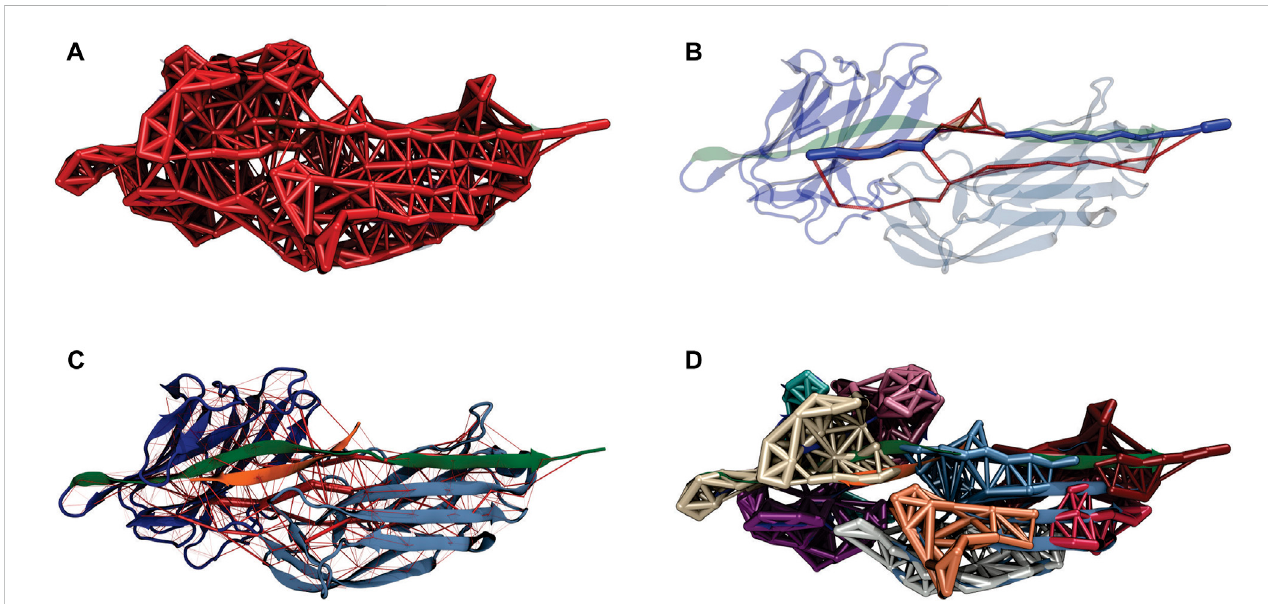
FIGURE 4 Bbp:Fg α dynamical network under high mechanical load. (A) Representation of the dynamical network. The thickness of the links between the nodes (amino acid residues) represents the correlation of motion between these residues. (B) The force propagates from the latch indirectly to the peptide, passing by the N2 domain of the protein. The color scheme of the complex is the same from Figure 1. The network ’ s optimal path is colored in dark blue while the sub-optimal pathsarecolored inred. (C) Fulldynamicalnetworkrevealingthemostcorrelatedregionsofthecomplex.Theweightofthenetwork edges (represented by the thickness of red tubes) is given by the betweenness values. (D) Generalized correlation-based communities represented by different colors of the nodes and edges in the network.